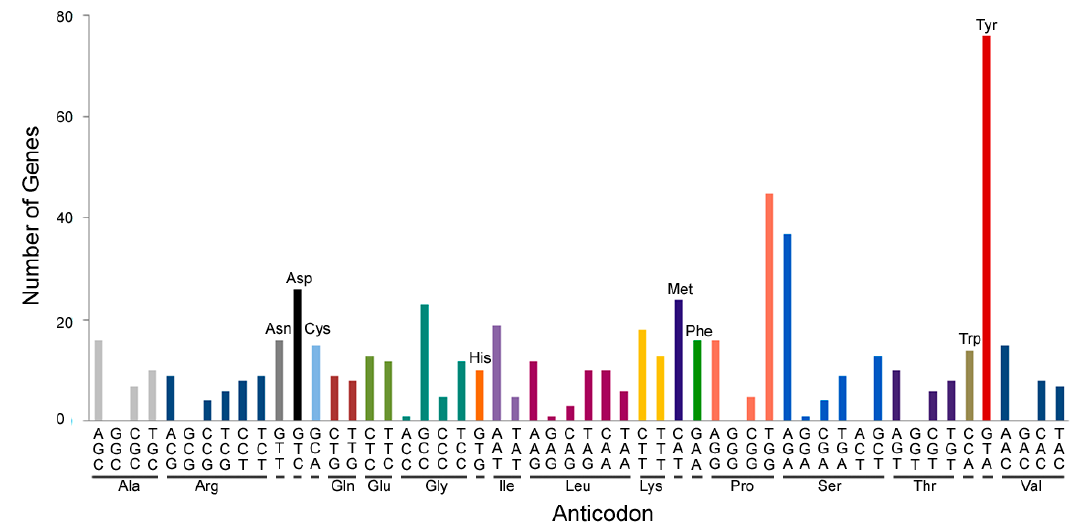
Figure 1. Multiple tRNA genes in Arabidopsis . Numbers of tRNA genes are presented for different amino acids and anticodons. Each graph with different colors indicates a different amino acid. Various isoacceptors (tRNA acceptors that accept the same amino acids) exist for each amino acid. Existence of isodecoders (tRNA genes with the same anticodon but different sequences elsewhere in the tRNA body) for each isoacceptor expand the source of tRNAs for generation of diverse tRFs.